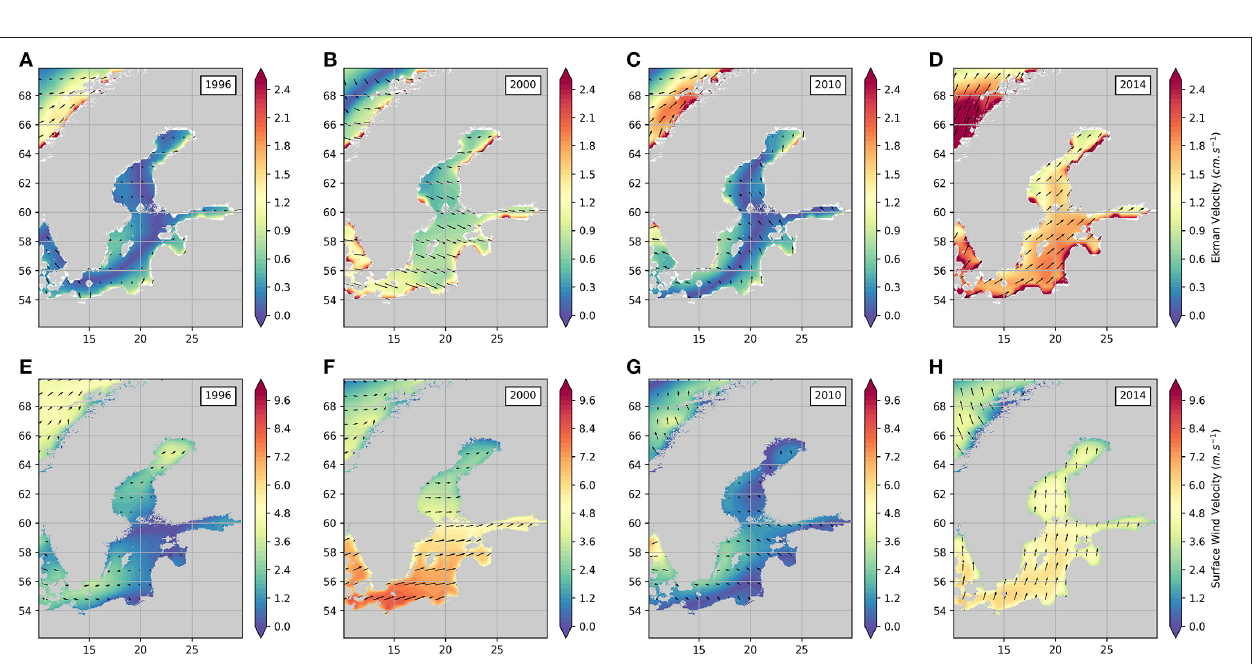
FIGURE 12 | Velocity of the Ekman currents (A–D) and surface wind velocity (E–H) during the winters of four selected years. The arrows represent the direction of the velocity vectors and are scaled according to their magnitude.